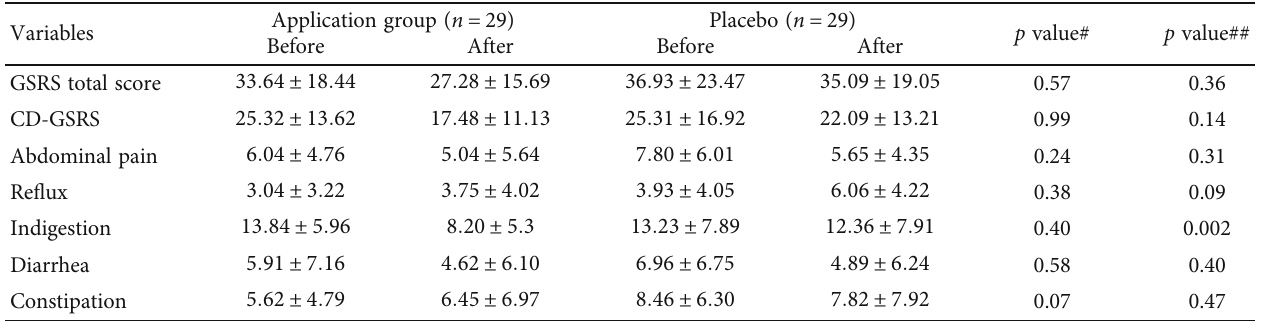
Table 2: The comparison of the GSRS total scores and subscores between studied